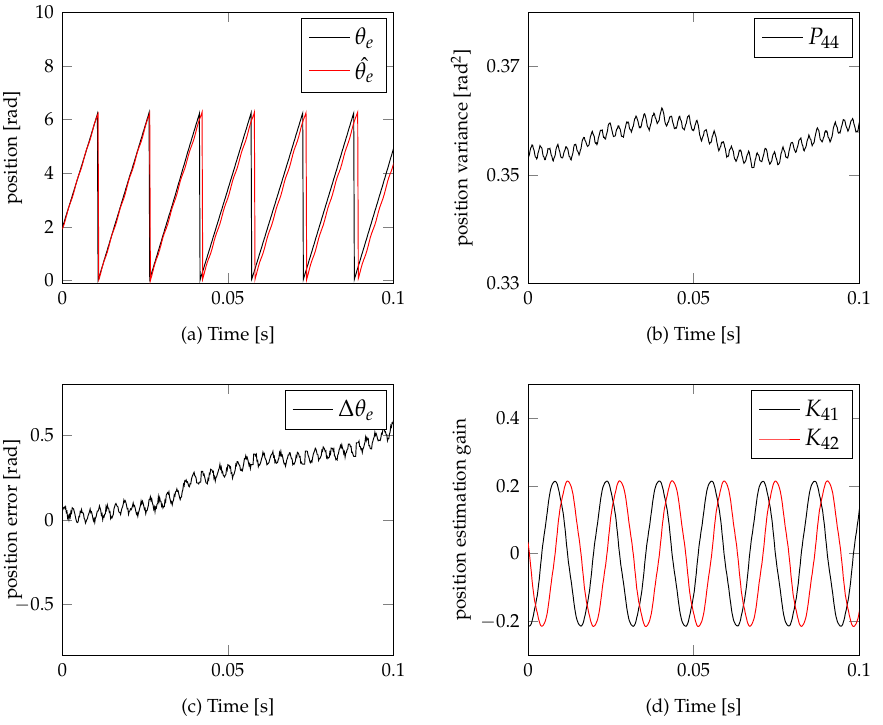
Figure 8. Experimental results of the rotor position estimation performance at f b = 5 kHz f s = 5 kHz and w e = 400 rads. ( a ) measured and estimated rotor positions, ( b ) estimated position error, ( c ) esti- mated position variance, ( d ) position estimation Kalman gains.